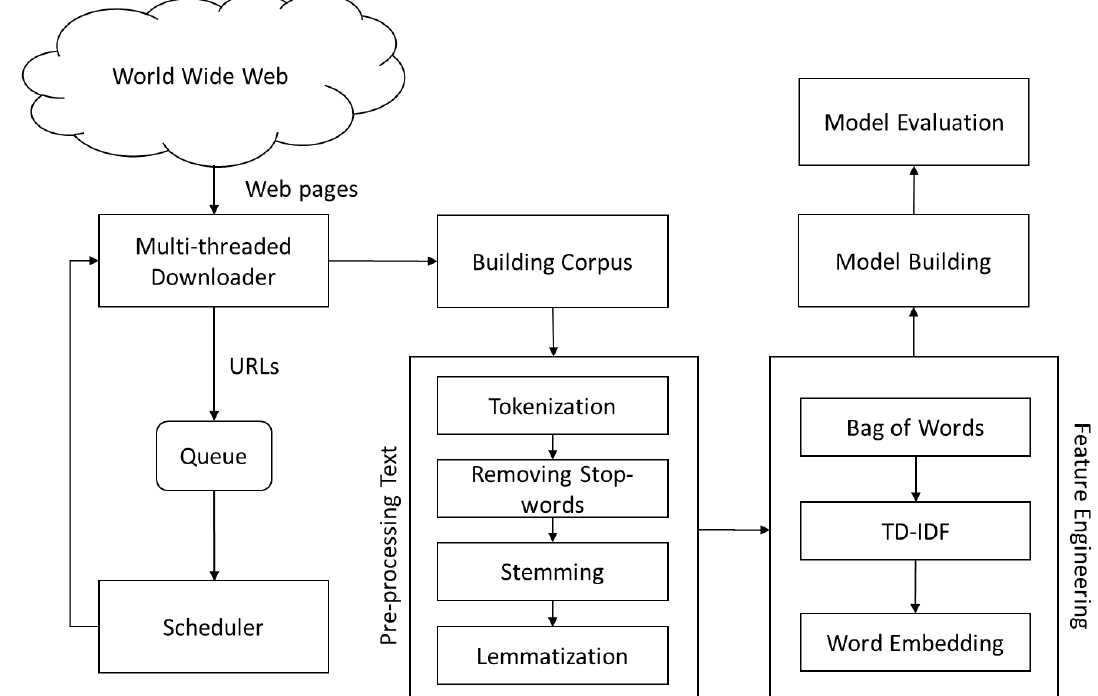
Figure 1. High-level architecture of the proposed